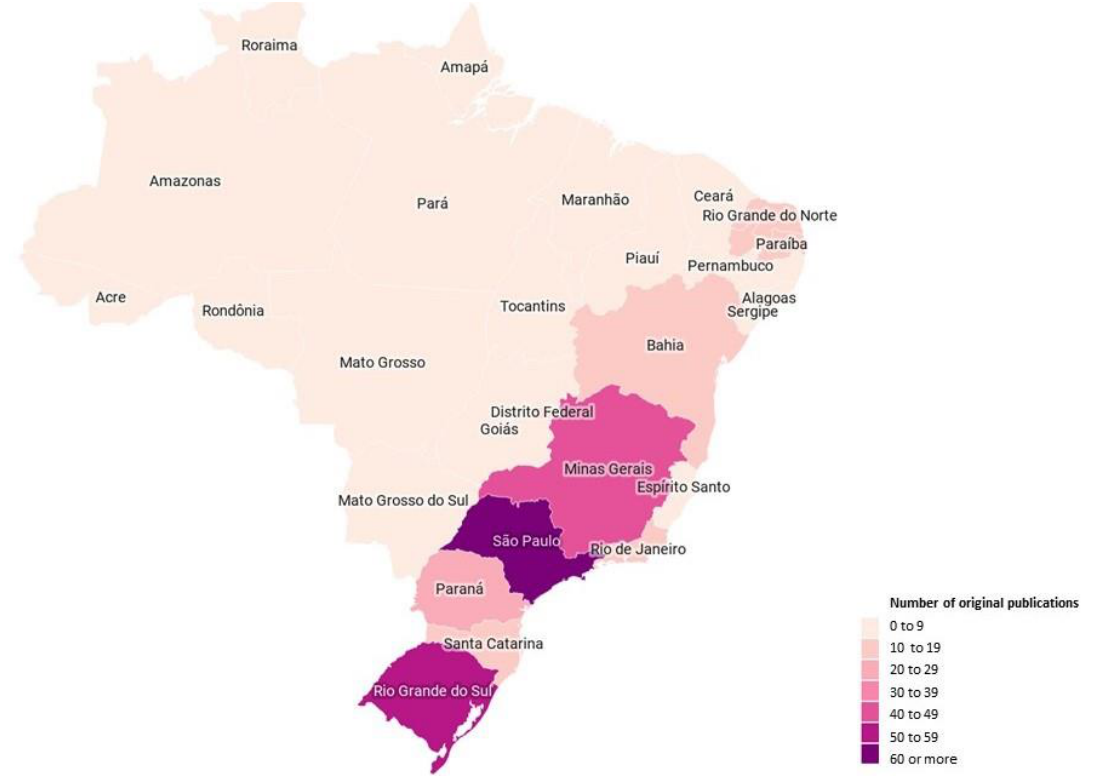
Figure 2. Characterization of the number of original publications included according to the Brazilian state of the institutional affiliation of the first author.